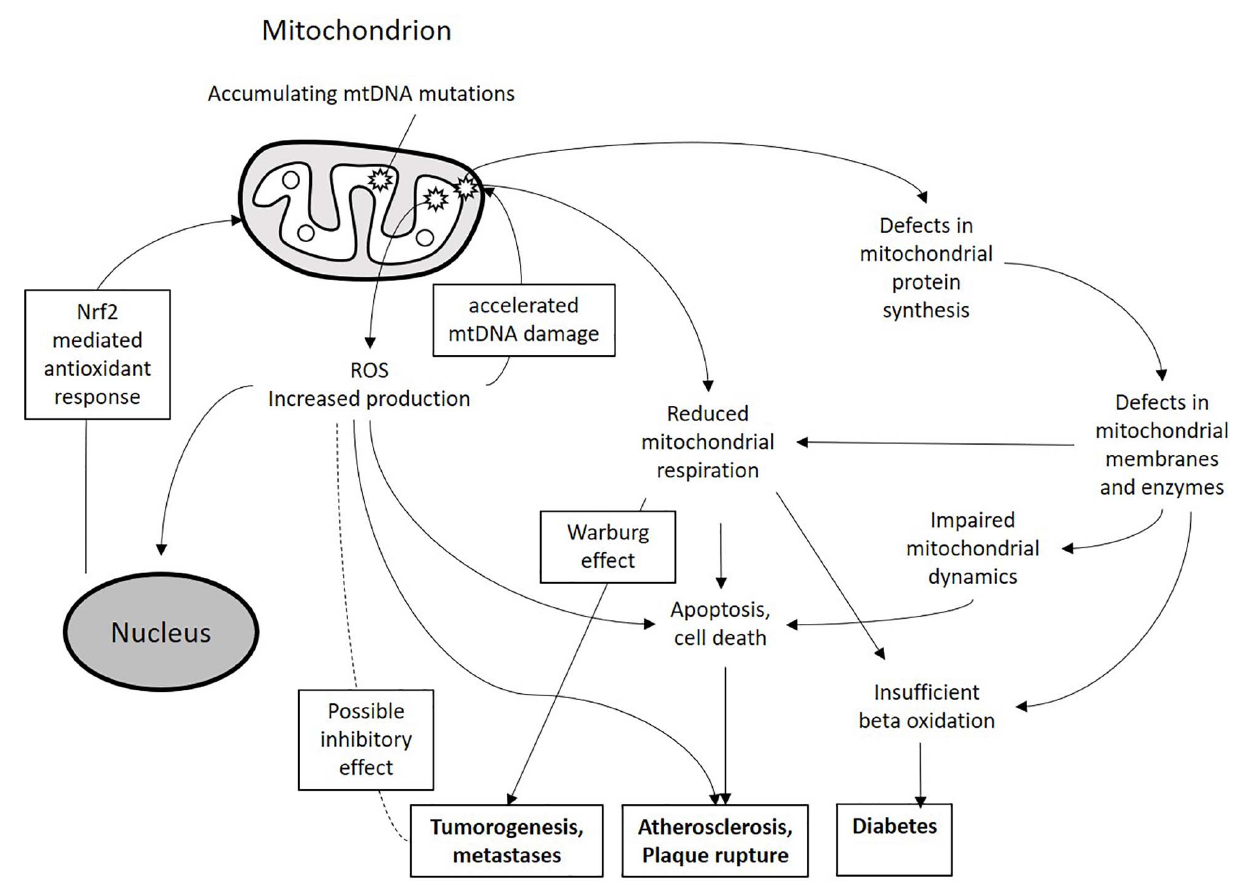
FIGURE 1 | Schematic presentation of the miutohcondrial dysfunction involvement in chronic pathologies. Accumulating mtDNA mutations and associated defects in mitochondrial proteins can lead to increased ROS production, reduced mitochondrial respiration and impaired mitochondrial dynamics. These processes can lead to alteration of cellular metabolism and increased cell death and apoptosis thus contributing to the development of pathological